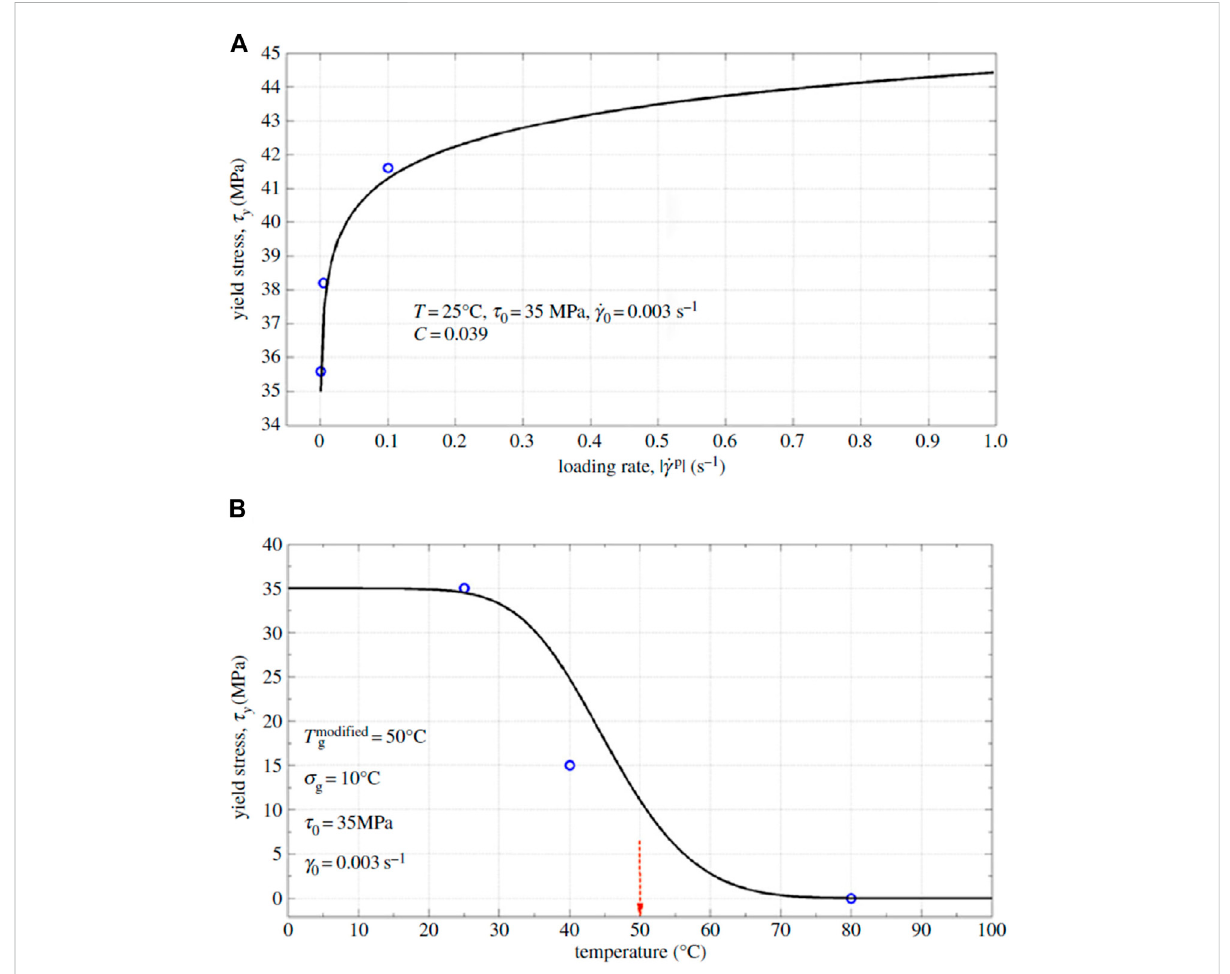
FIGURE 14 Comparison of experimental and simulation results for (A) strain rate-dependent and (B) temperature-dependent yield stresses.Circlesdenote experimentalresults,andthesolidlinedenotessimulationresults(ShojaeiandLi,2014).[ReproducedwithpermissionfromProceedingsoftheRoyal Society A, 470: 20140199., (2014). Copyright 2014 Royal